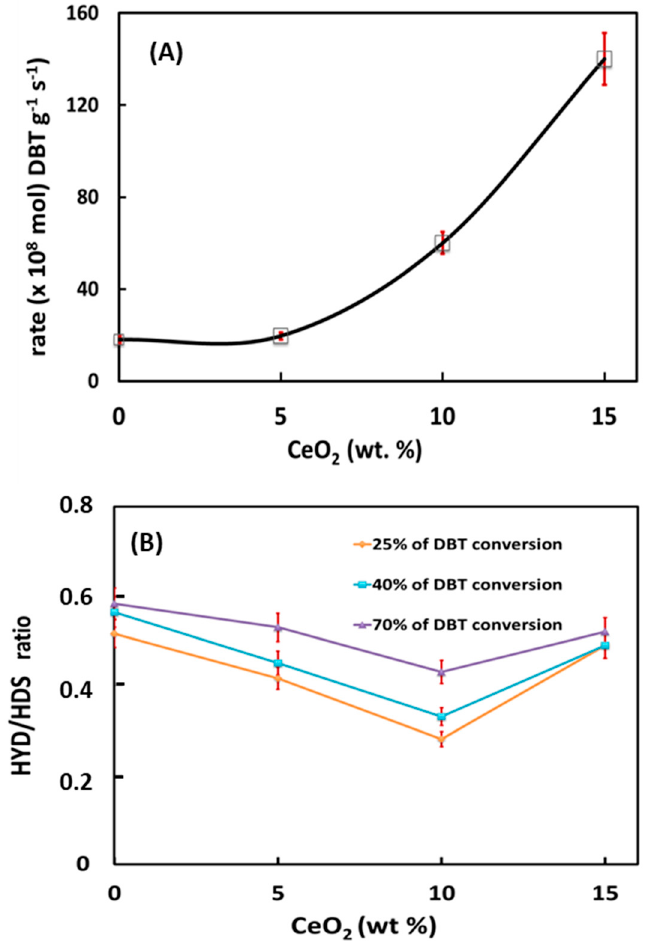
Figure 9. HDS of the DBT reaction (a batch reactor, 350 ◦ C, and 3.1 MPa H 2 pressure) over NiMoW/Al and NiMoW/Al-Ce( x ) sulfided catalysts ( x = 5, 10 and 15 CeO 2 wt.%): ( A ) initial reaction rates vs. CeO 2 loading in Al 2 O 3 -CeO 2 support and ( B ) comparison of the HYD/DDS ratio at the same DBT conversion (ca. 25, 40, and 70%). Table 4. DBT conversions and HYD/DDS ratios of the catalysts stabilized during 5 h of reaction time a .